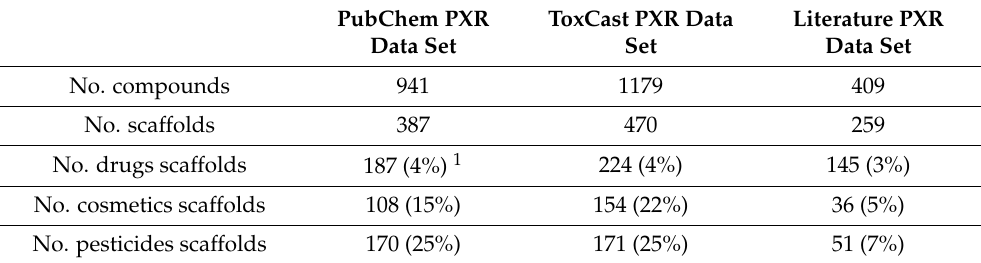
Table 2. Overview of the Composition of PXR Data Sets Utilized in this